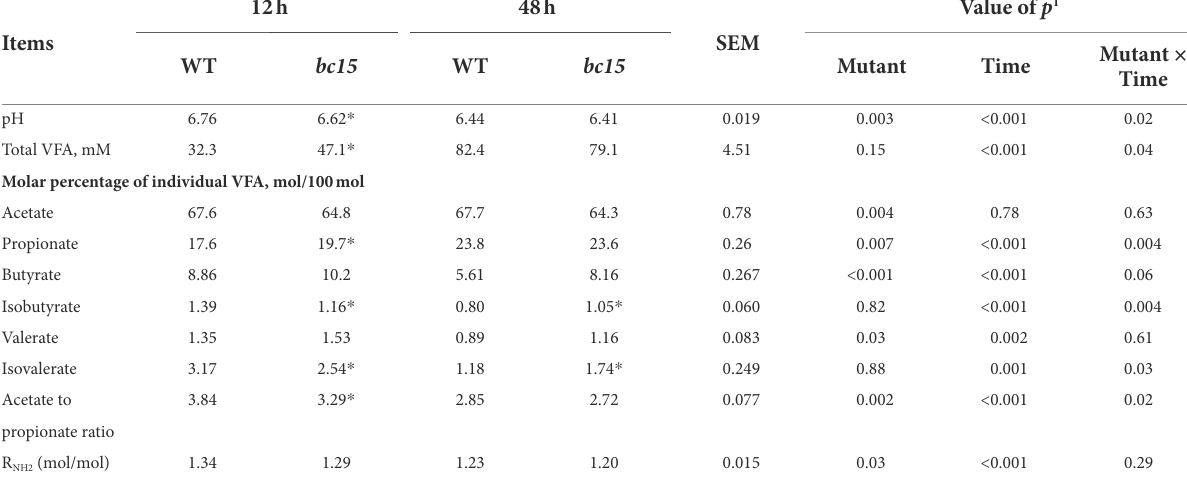
TABLE 5 Fermentation characteristics of wild-type (WT) and brittle culm 15 ( bc15 ) mutant rice straws after 12- and 48-h in vitro ruminal incubation ( n = 3).